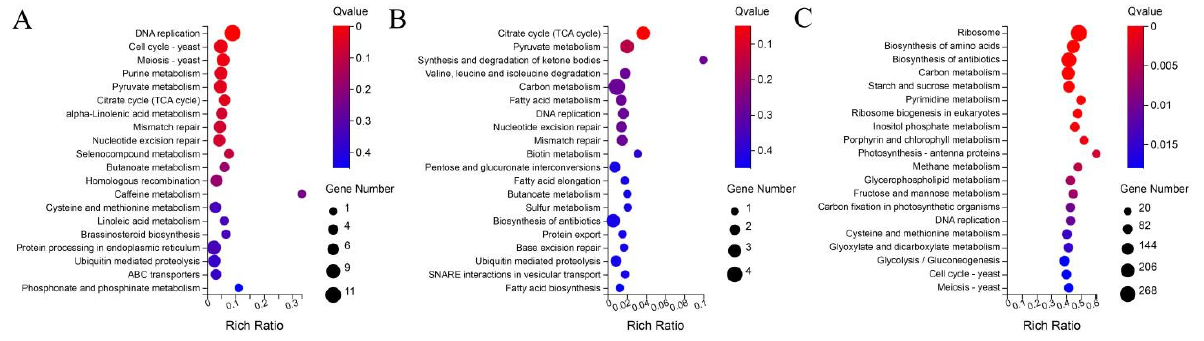
Figure 6. KEGG enrichment analysis of individual DEGs in three different periods. ( A ) KEGG analysis of DEGs at the early time point. ( B ) KEGG analysis of DEGs at the middle time point. ( C ) KEGG analysis of DEGs at the late time point.